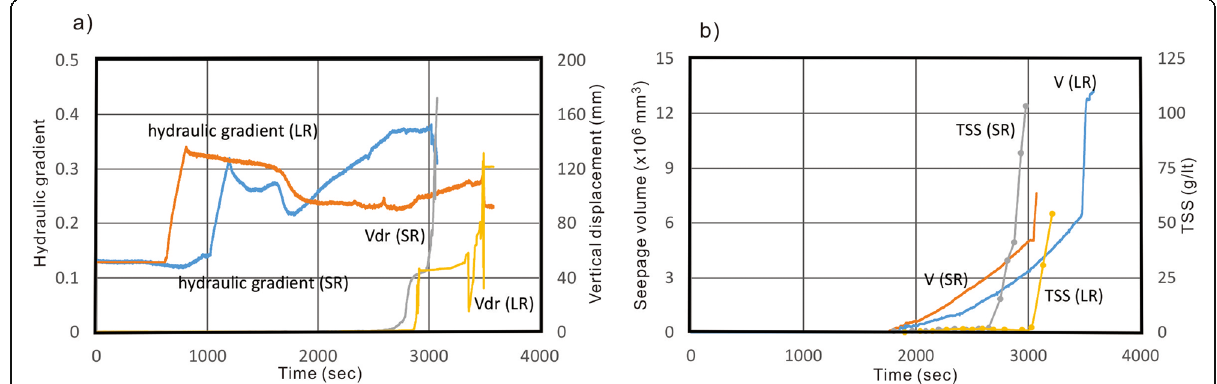
Fig. 7 Time series data of hydraulic gradient, vertical displacement, seepage volume and TSS for the sample S568 at a small reservoir (SR) and large reservoir (LR). a Hydraulic gradient and vertical displacement; b Seepage volume and TSS